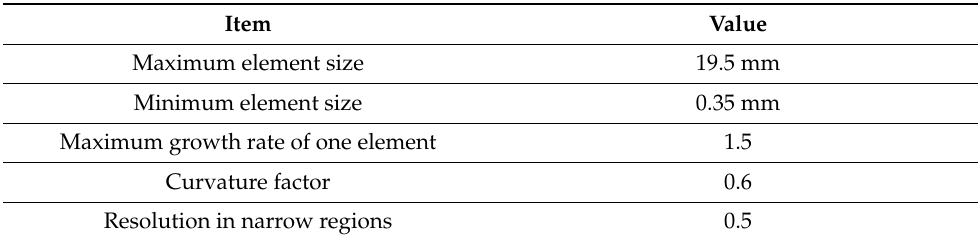
Table 2. Parameters of the tetrahedral mesh generated in Comsol.